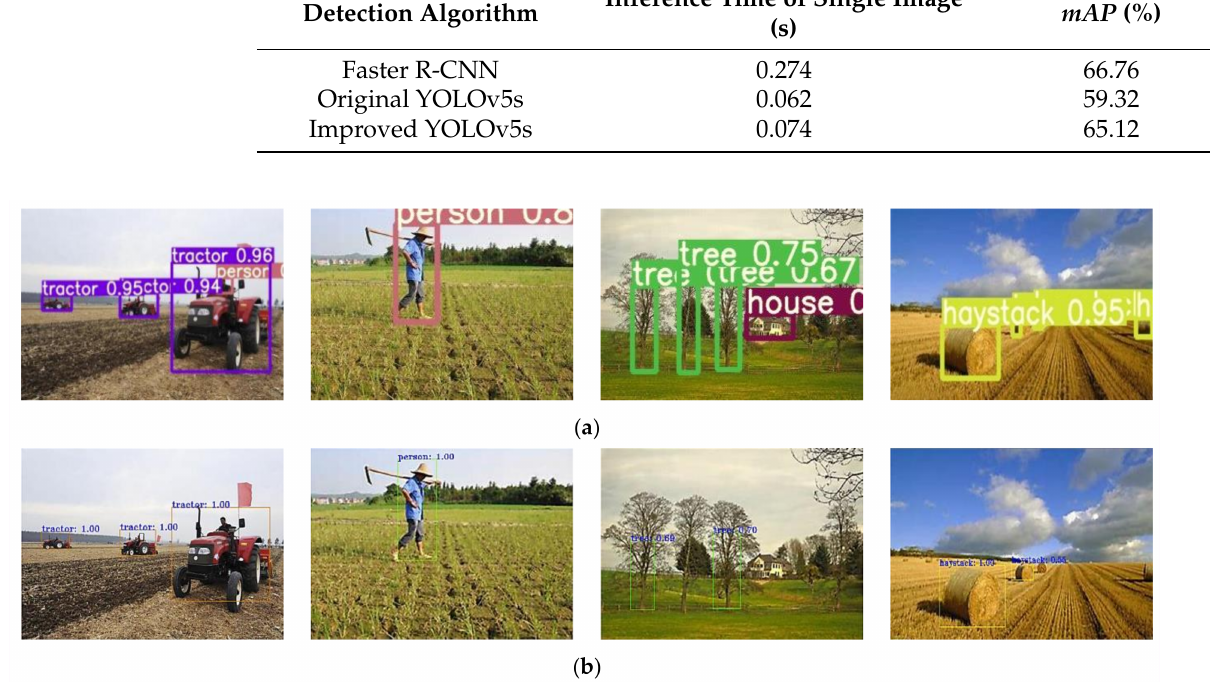
Figure 12. Comparison of detection effects of improved YOLOv5s and Faster R-CNN. ( a ) detection effects of the improved YOLOv5s; ( b ) detection effects of the Faster